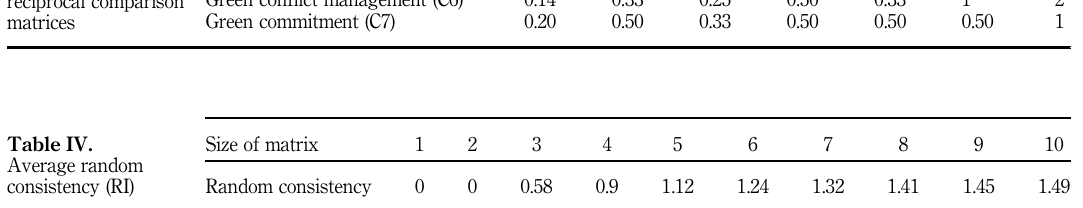
Table III. AHP pairwise positive reciprocal comparison matrices